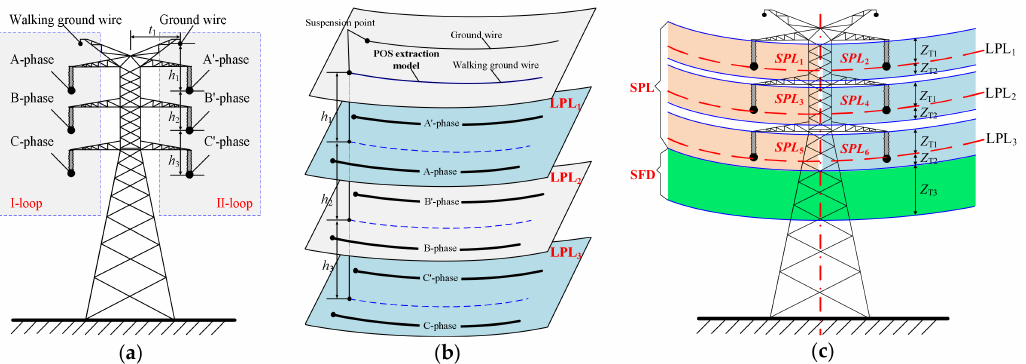
Figure 5. The schematic of power line partition: ( a ) erection specification of power line; ( b ) partition at the layer-level; ( c ) partition at the